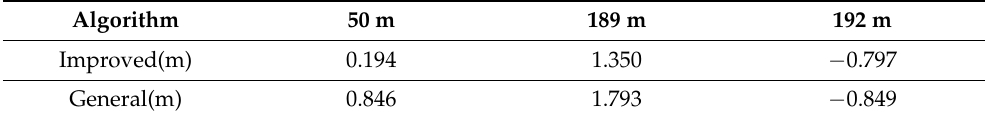
Table 2. Maximum front wheel angle error.